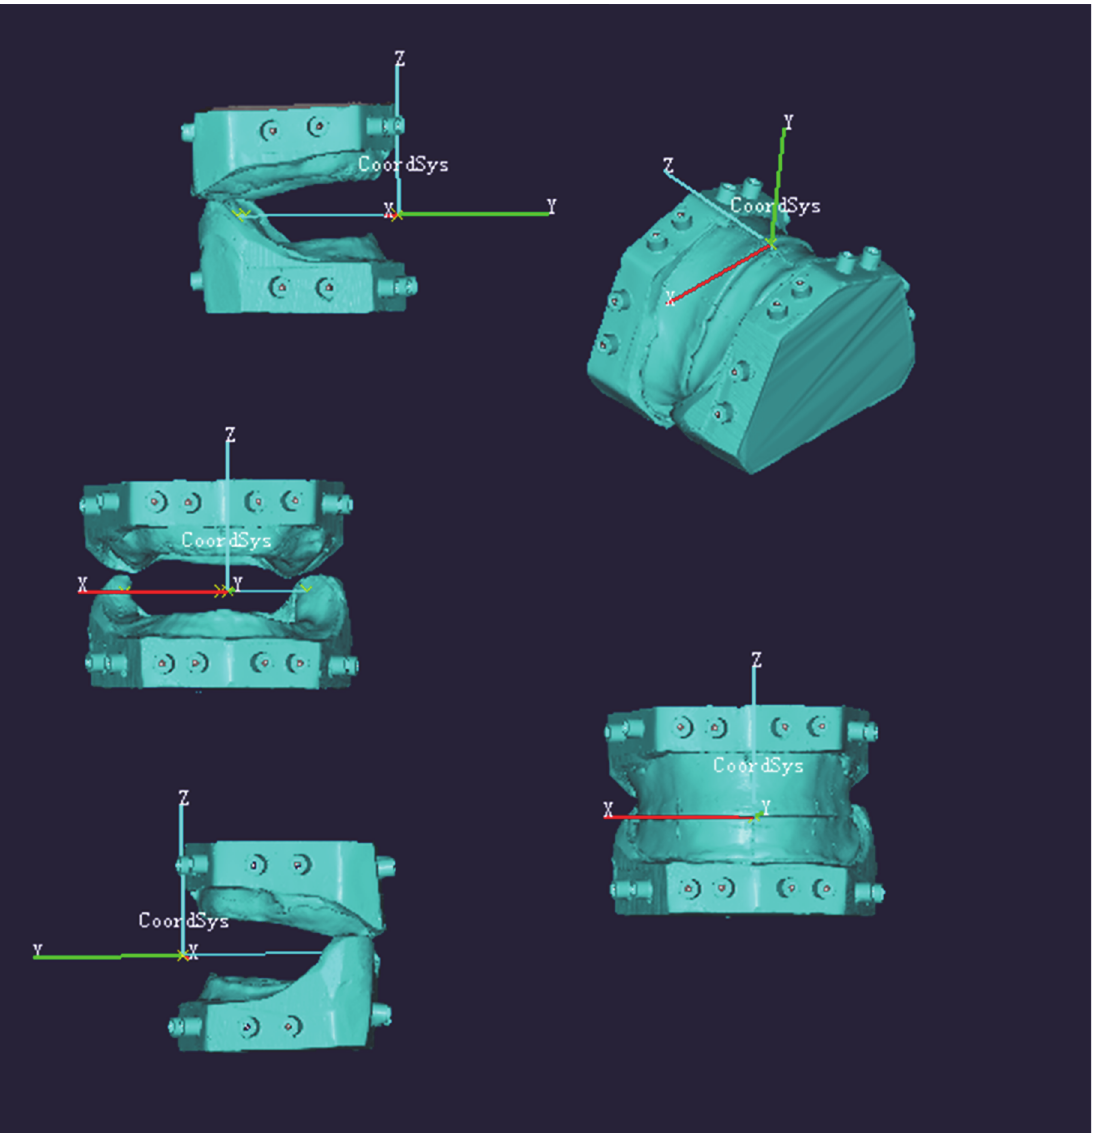
Fig 4. Observation coordinate system.